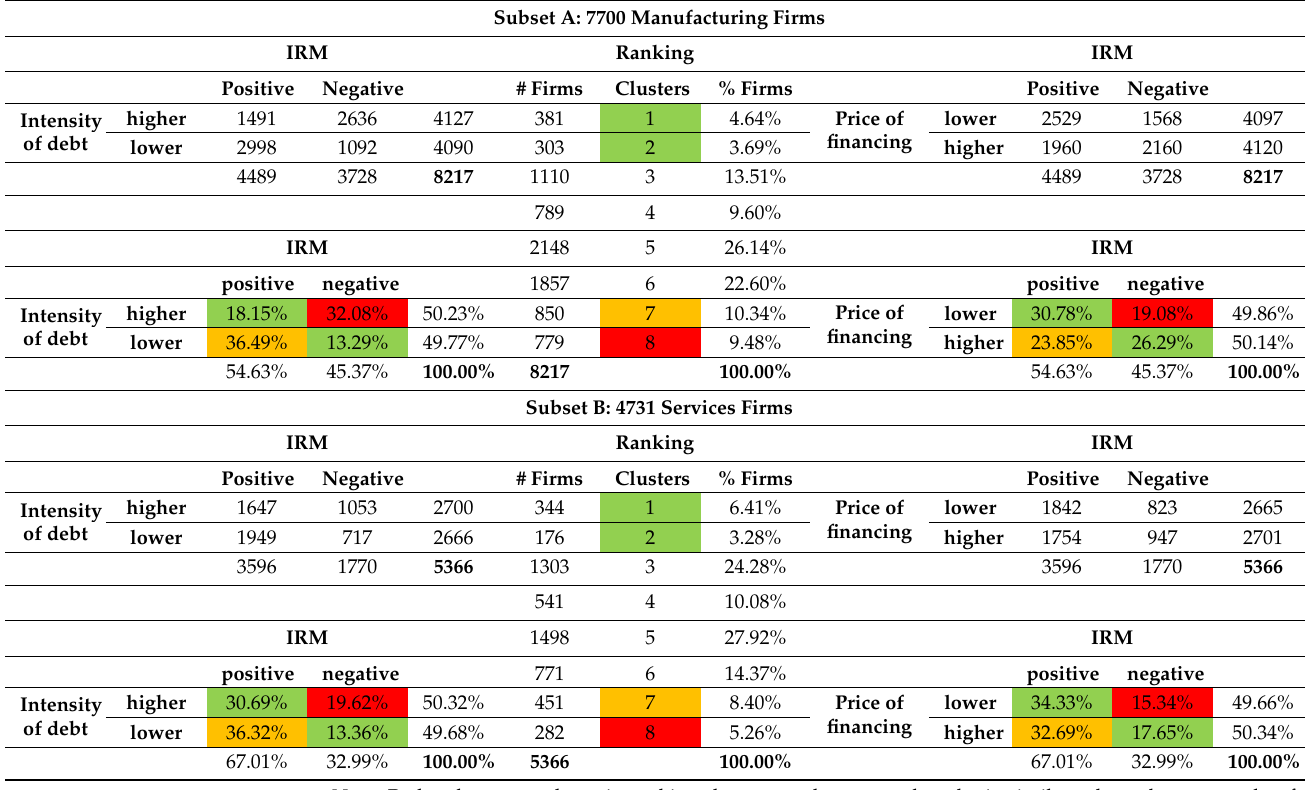
Table 5. Subset overlaps between IRM results, intensity of debt (left) and price of financing (right). Subset A: 7700 Manufacturing